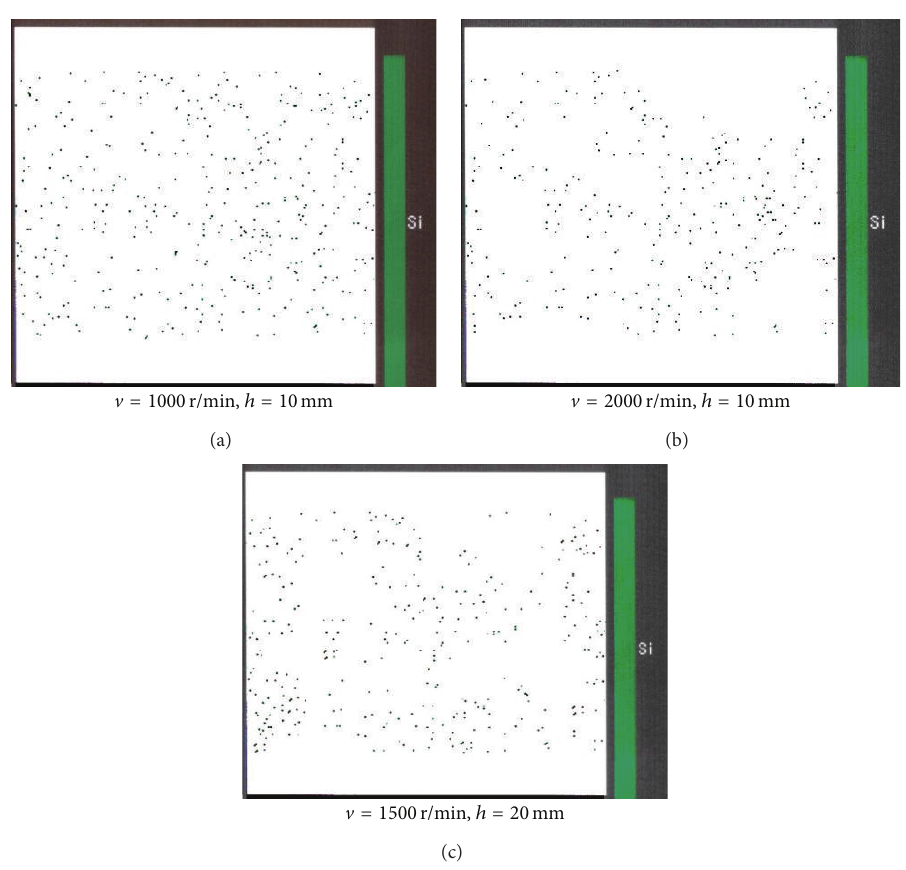
Figure 7: Content distribution of SiO 2 in composite coatings using an electron probe. Table 2: Data of minimum mixing time, average 0-dimensional and 1-dimensional Betti numbers, and amplitude at different rotating speeds and paddle heights with 𝐼 = 0.25